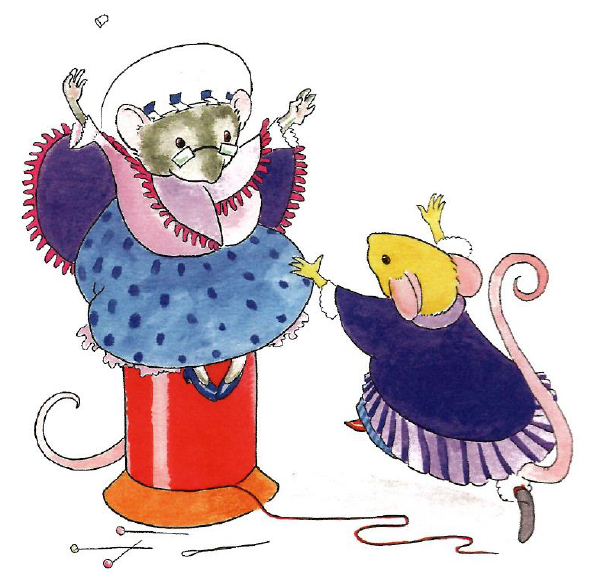
Figure 11. McMaster’s illustration for The Beautifull Cassandra (Austen 2021), p. 24.